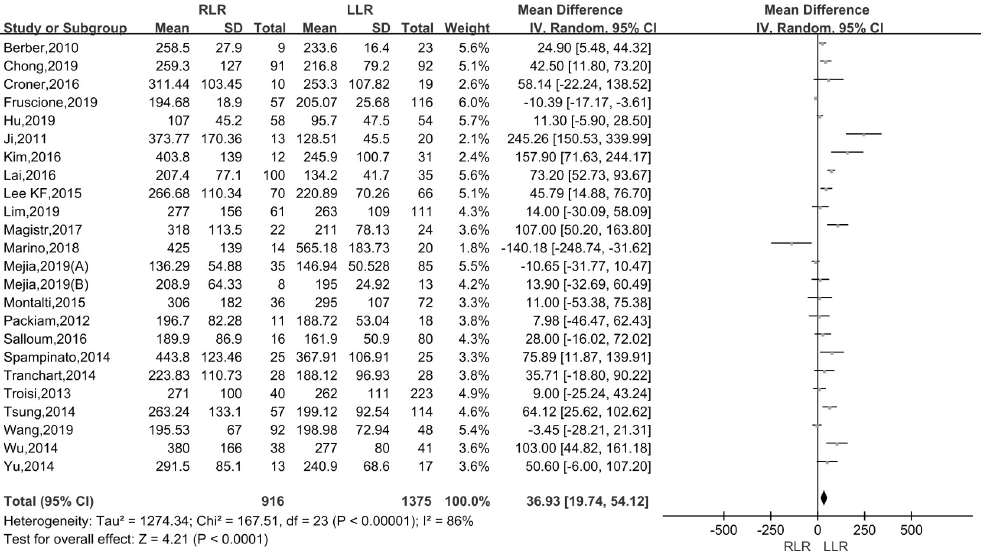
Fig 2. Forest plot of the meta-analysis on operative